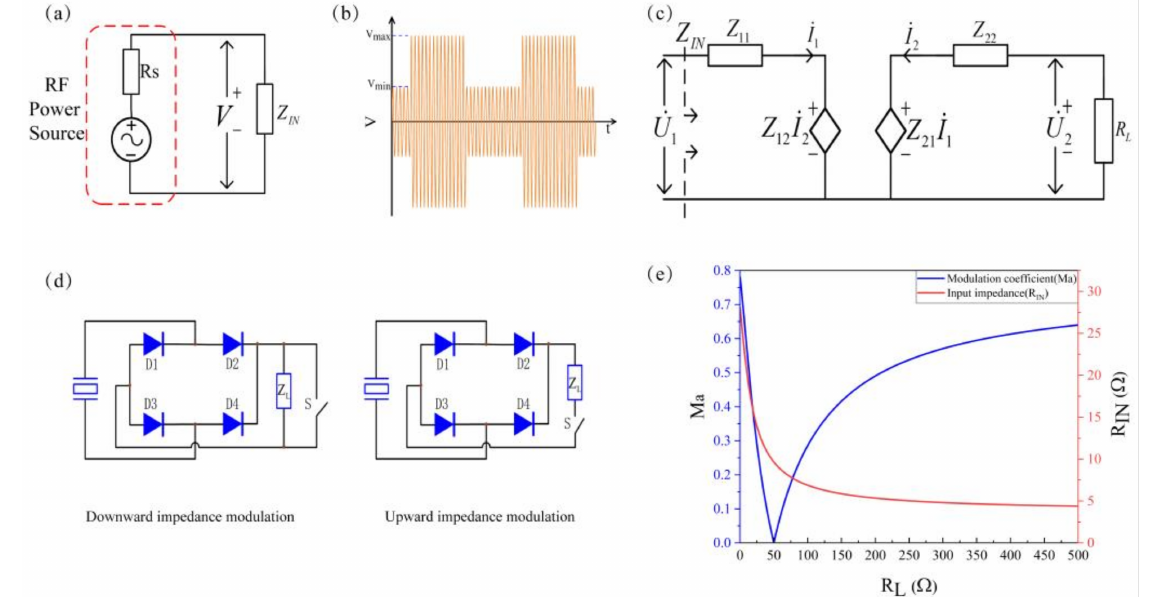
Figure 4. Impedance modulation. ( a ) Impedance modulation circuit model. ( b ) Modulated carrier on the terminals of E-PZT. ( c ) Equivalent circuit model of the channel. ( d ) Traditional impedance modu- lation method. ( e ) Modulation coefficient and Input impedance as the function of load